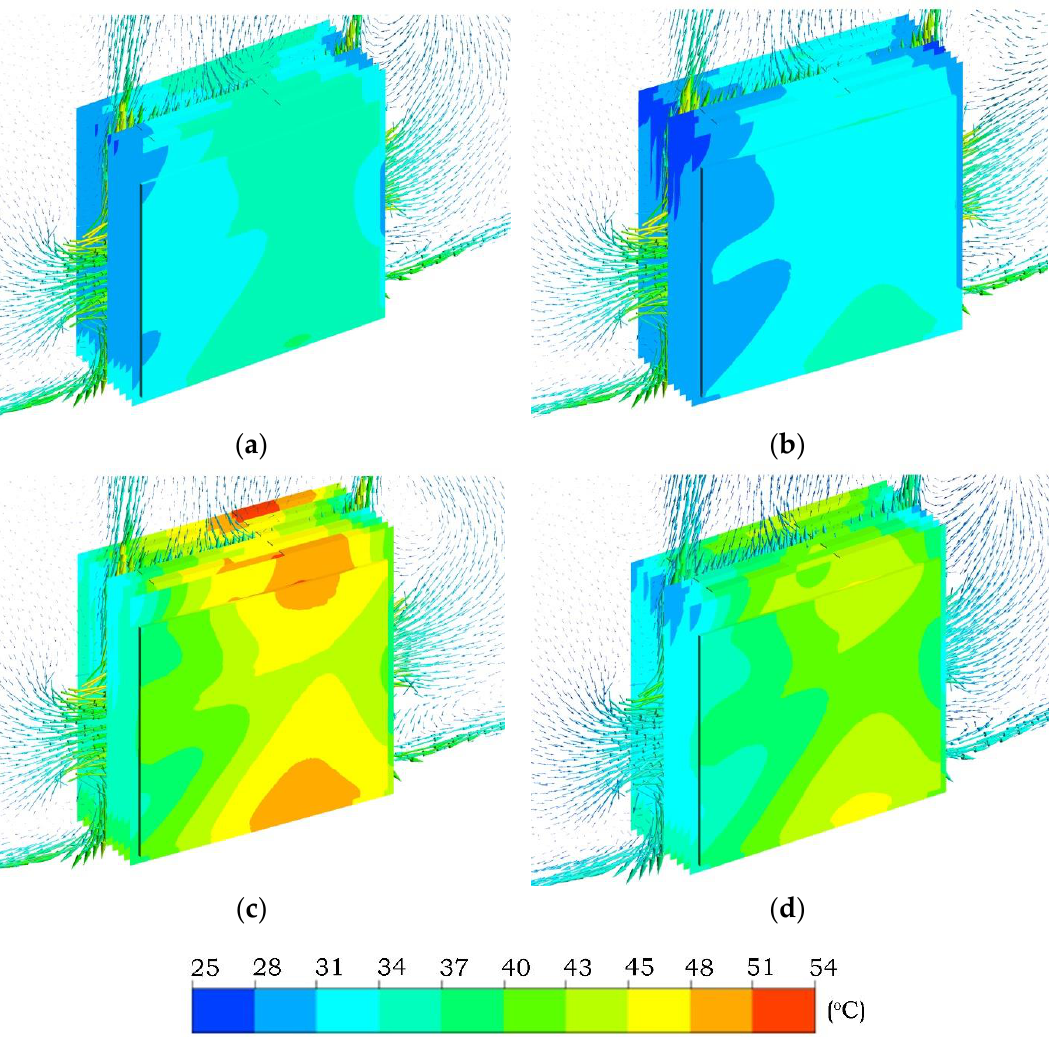
Figure 9. Temperature distribution with the flow direction vector of the battery module after 3C and 5C discharging conditions: ( a ) 3000 rpm at 3C, ( b ) 3800 rpm at 3C, ( c ) 3000 rpm at 5C, and ( d ) 3800 rpm at